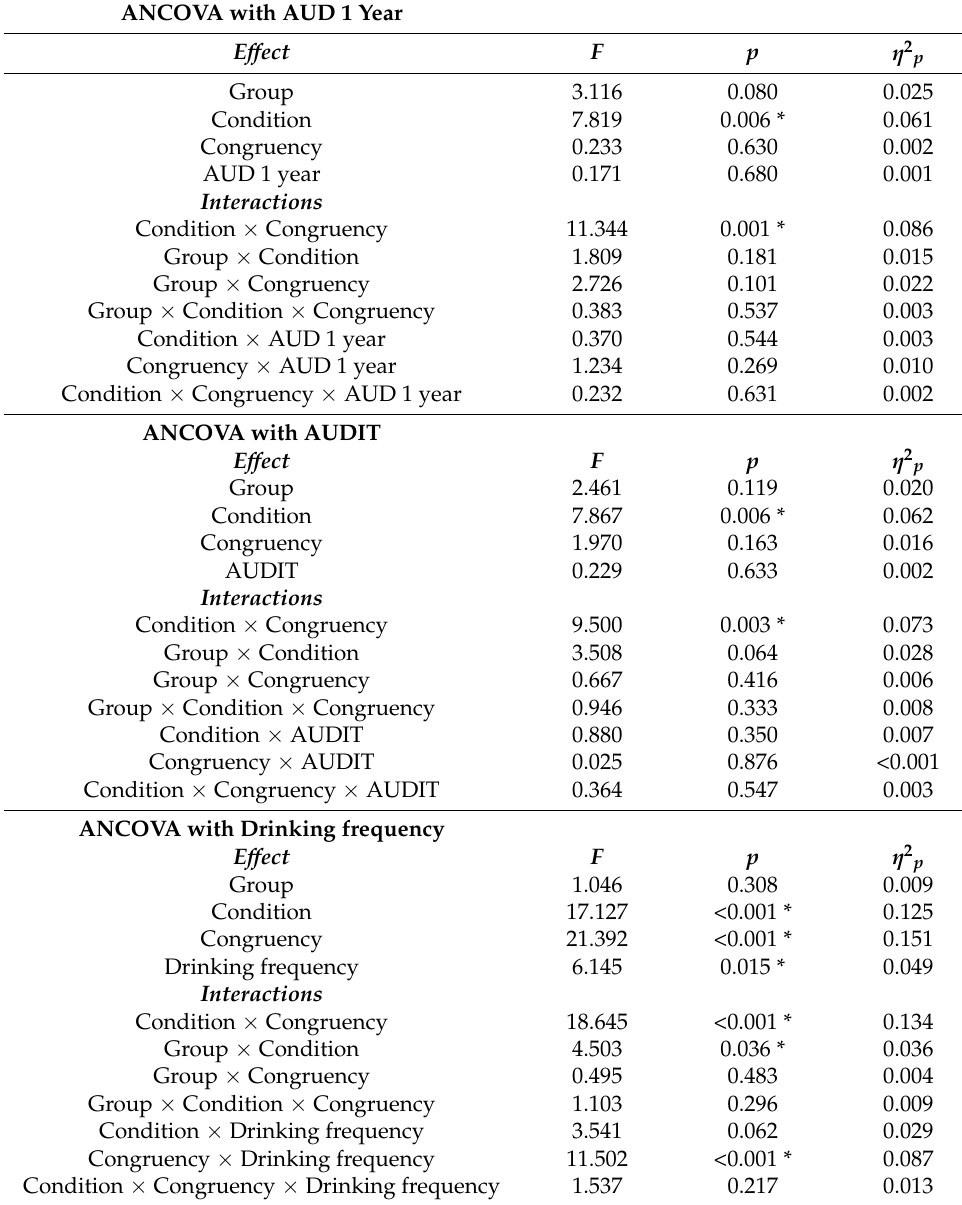
Table 4. ANCOVA results for main effects and